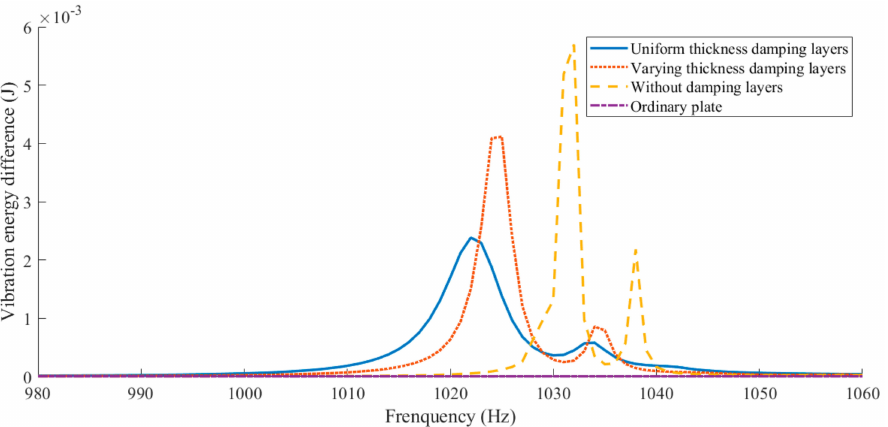
Figure 15. The vibration energy difference of ABH plates embedded with different damping configu- rations and a reference plate with BC 1.